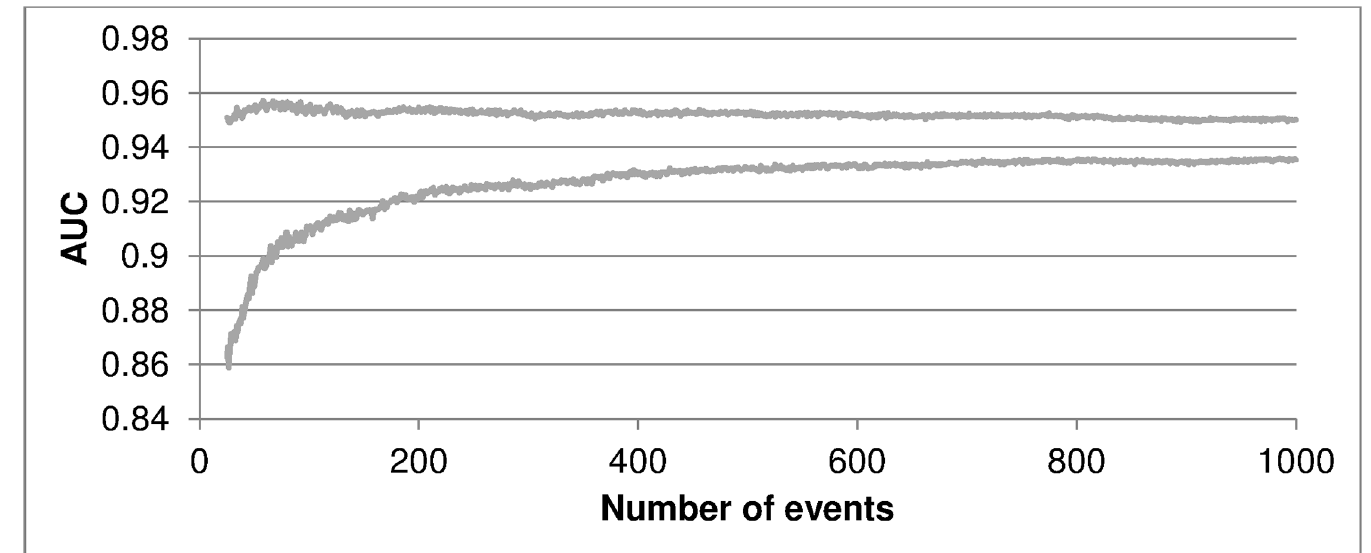
Fig 1. Confidence intervals for the area under the ROC curve according to the number of events in the sample. AUC, area under the ROC curve.